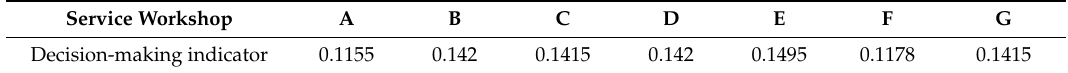
Table 6. The indicator values Dc of the service workshop selection decision ‐ making.